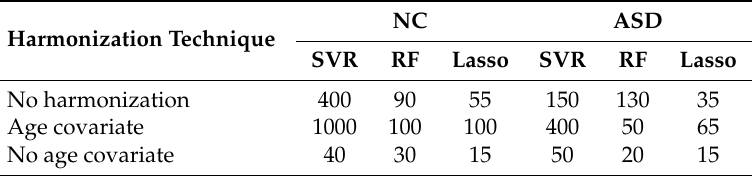
Table 1. Number of ranked features k opt at which the regression models exhibit the minimum average Mean absolute error